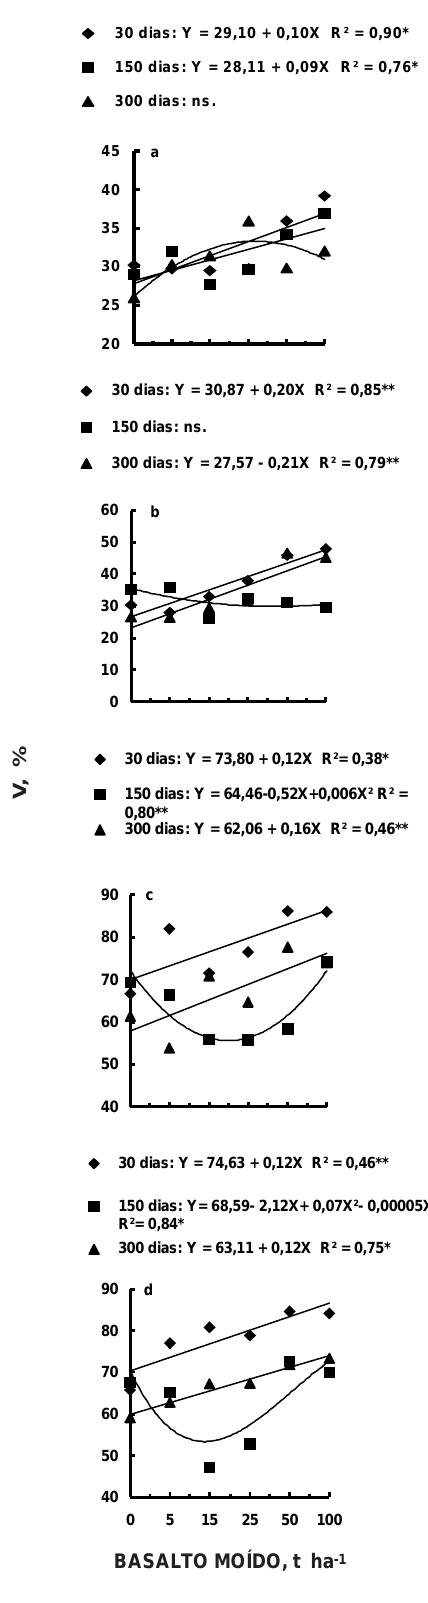
BASALTO MOÍDO, t ha -1 Figura 8. Saturação de K + Ca + Mg na CTC (Valor V) Figura 7. Soma de K, Ca e Mg trocáveis (Valor S) em de um Latossolo Vermelho-Escuro e de um um Latossolo Vermelho-Escuro e em um Podzólico Podzólico Vermelho-Amarelo incubados com Vermelho-Amarelo tratados com doses crescentes doses crescentes de basalto microcristalino de basalto microcristalino (respectivamente, (respectivamente, figura 8a, c) e de olivina- basalto (respectivamente, figura 8b, d), após 30, figura 7a, c) e de olivina-basalto (respectivamente, 150 e 300 dias de figura 7b, d), após 30, 150 e 300 dias de incubação.